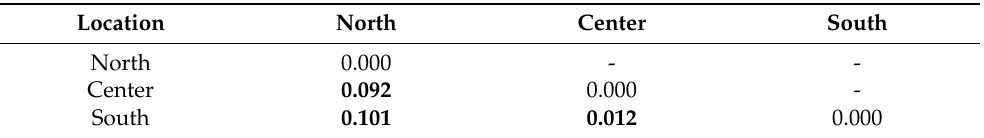
Table 2. Pairwise FST values between the Micropogonias furnieri populations of the three different locations for the 12 microsatellite